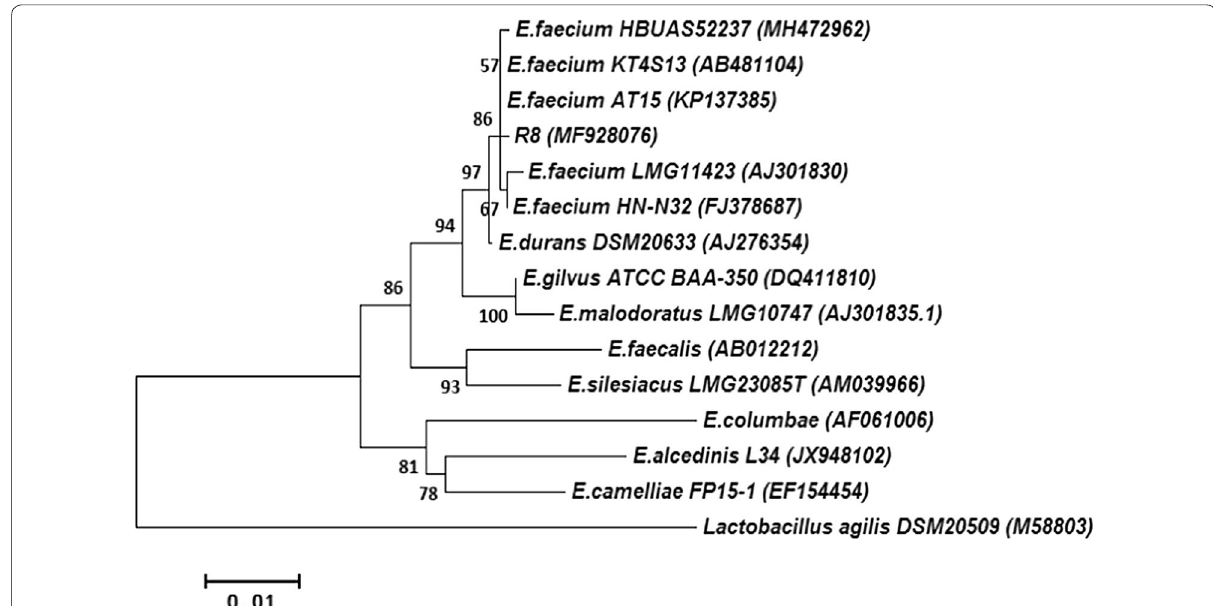
Fig. 1 Phylogenetic tree analysis of the bacterial strain R8 based on 16S rRNA gene sequences. The R8 strain was grouped in the Enterococcus faecium cluster, and it was most closely related to Enterococcus faecium KT4S13 and